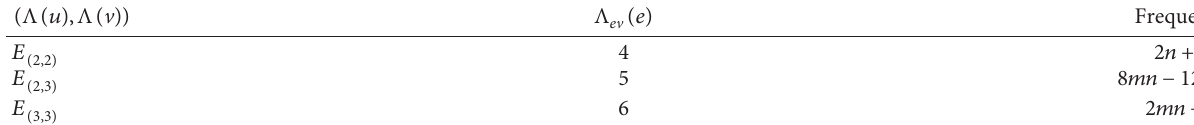
Figure 1: Structure of multiple segment linear hexagonal chains L [ m,n ] . Table 1: The edges’ ev-degree of L [ m, n ] .